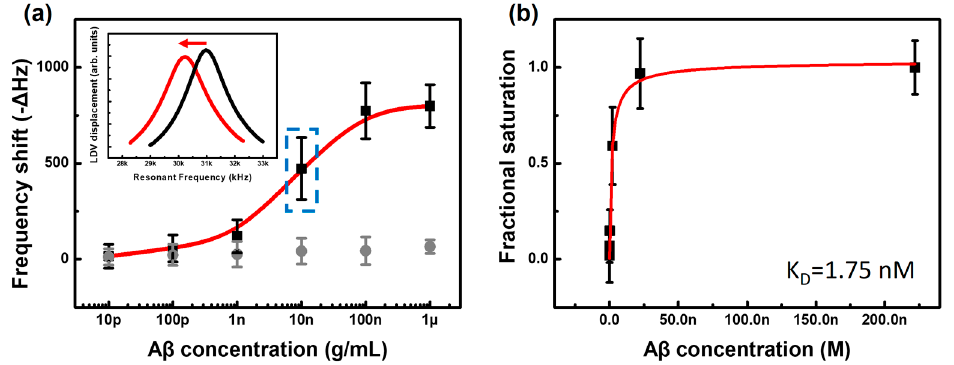
Figure 4. Quantification of A β 42 peptide as a target analyte using the slit cantilever. ( a ) Responses of resonant frequency vs. logarithmic concentration of analytes (black square) and negative control with PSA protein (grey circle); ( b ) Estimation of the dissociation constant of specific recognition by fitting the thermodynamic isotherm model.